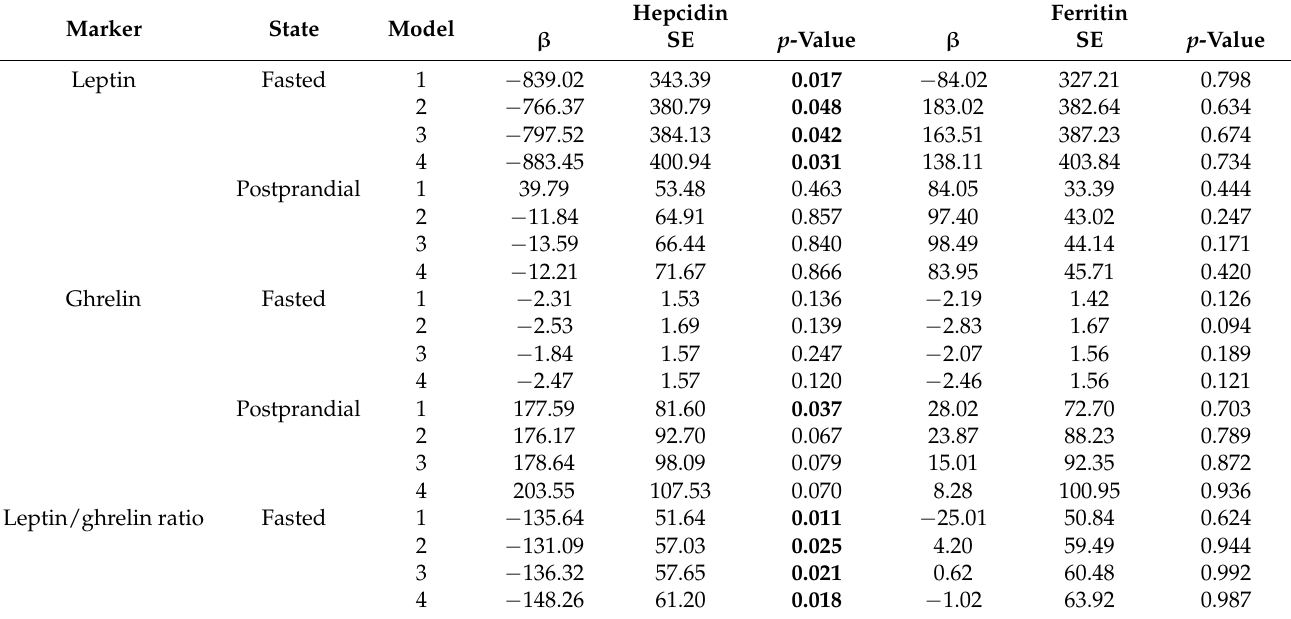
Table 2. Associations between hepcidin, ferritin, and markers of energy balance in the fasted and postprandial